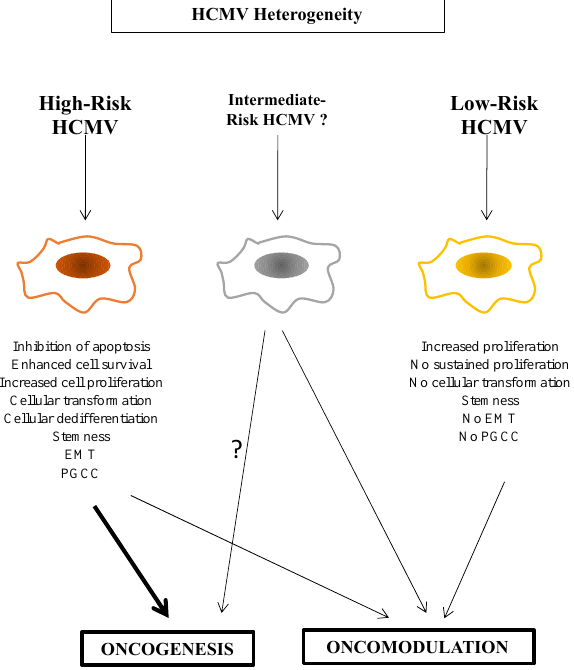
Figure 1. Oncomodulation, oncogenesis, and HR/LR HCMV strains.